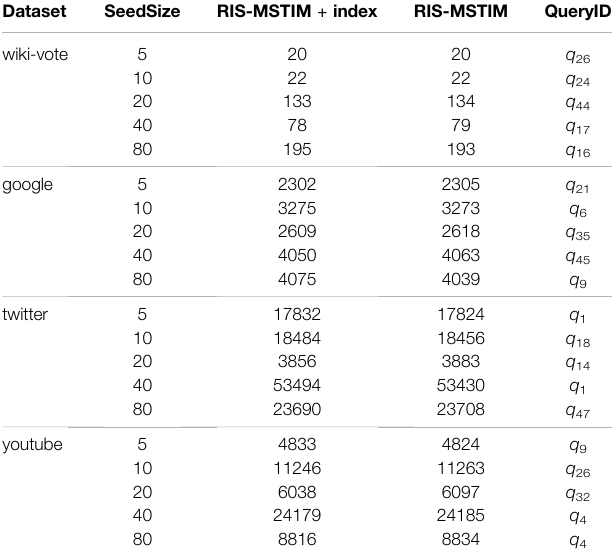
TABLE 3 | In fl uence of the